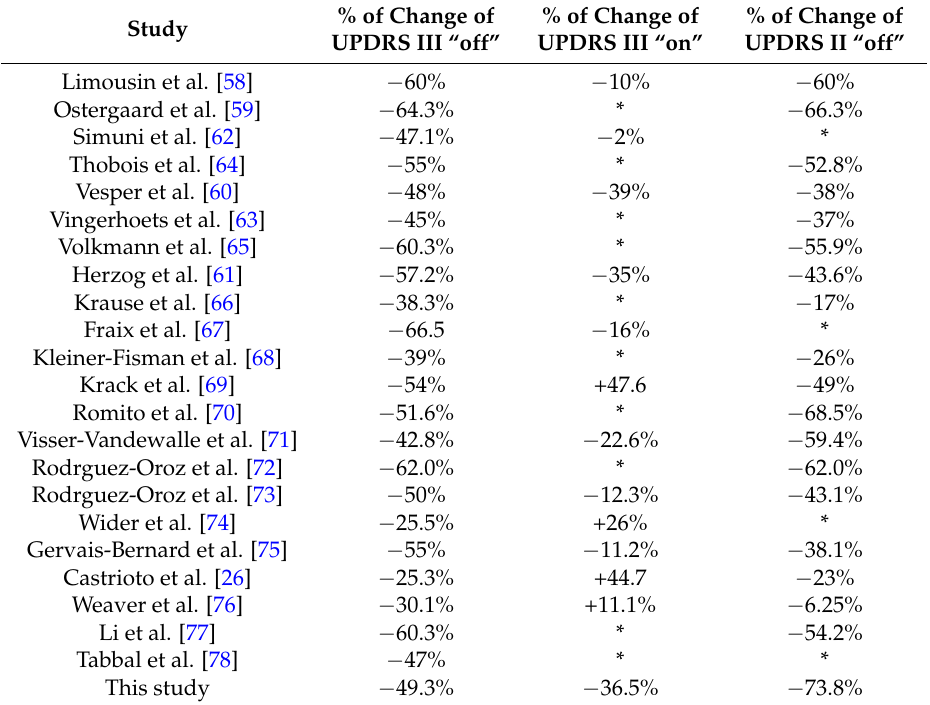
Table 7. Motor and activity of daily living outcomes of patients in previous studies of bilateral subthalamic nucleus stimulation in PD.